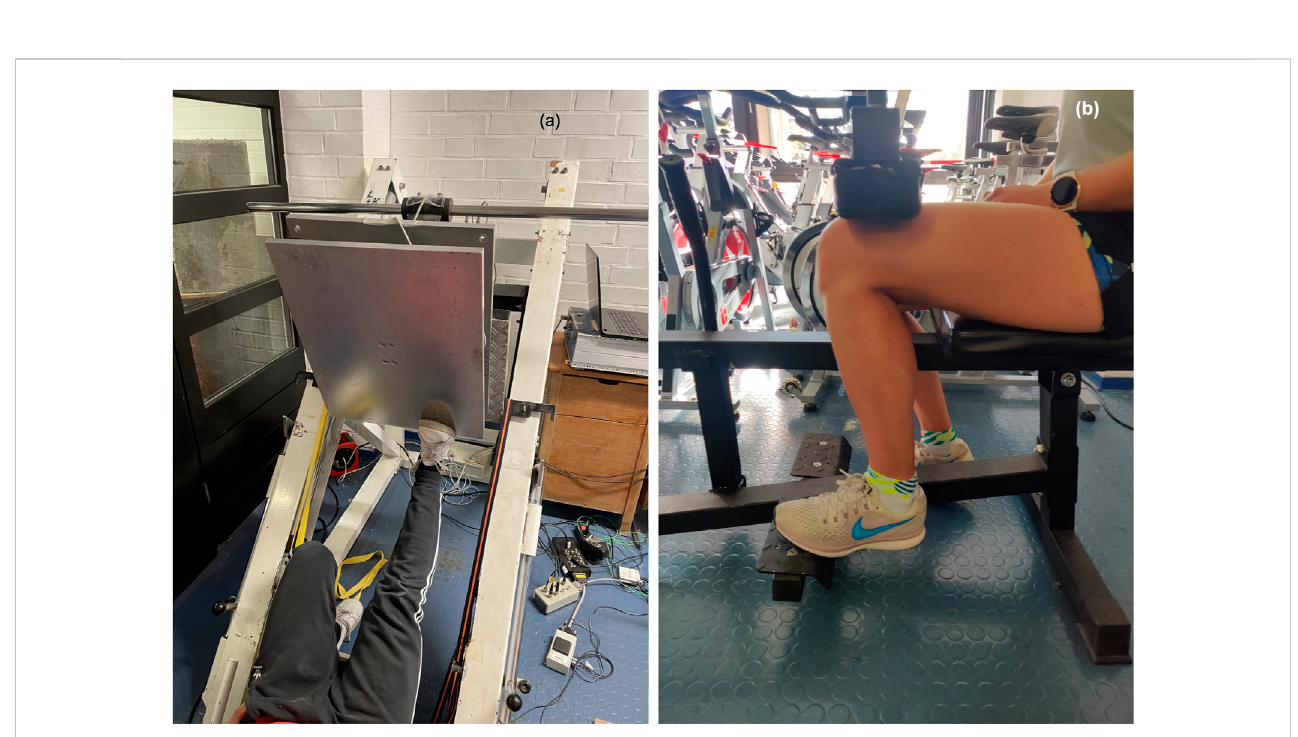
FIGURE 2 Measurement of MSt in the extended knee joint (A) and the fl exed knee joint (B) .